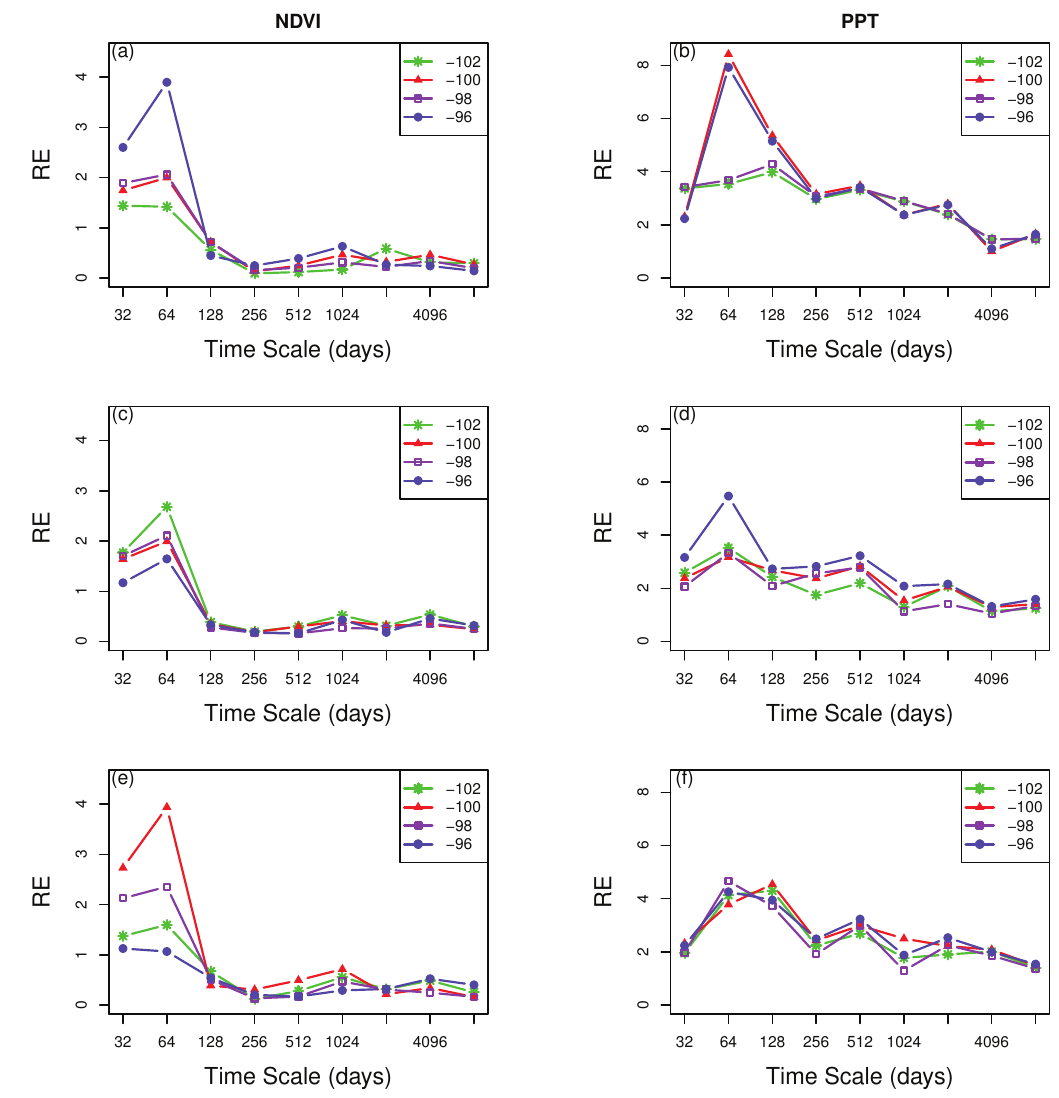
Figure 8. Multi-resolution relative entropy of NDVI ( left ) and PPT ( right ) as a function of temporal scale in ( a ) entire KRB, ( b ) whole KRB, ( c , d ) irrigated corn, ( e , f ) C4 grassland for selected longitudes: 102 W (green line with star), 100 W (red line with triangle), 98 W (purple line with rectangle) and 96 W (blue line with